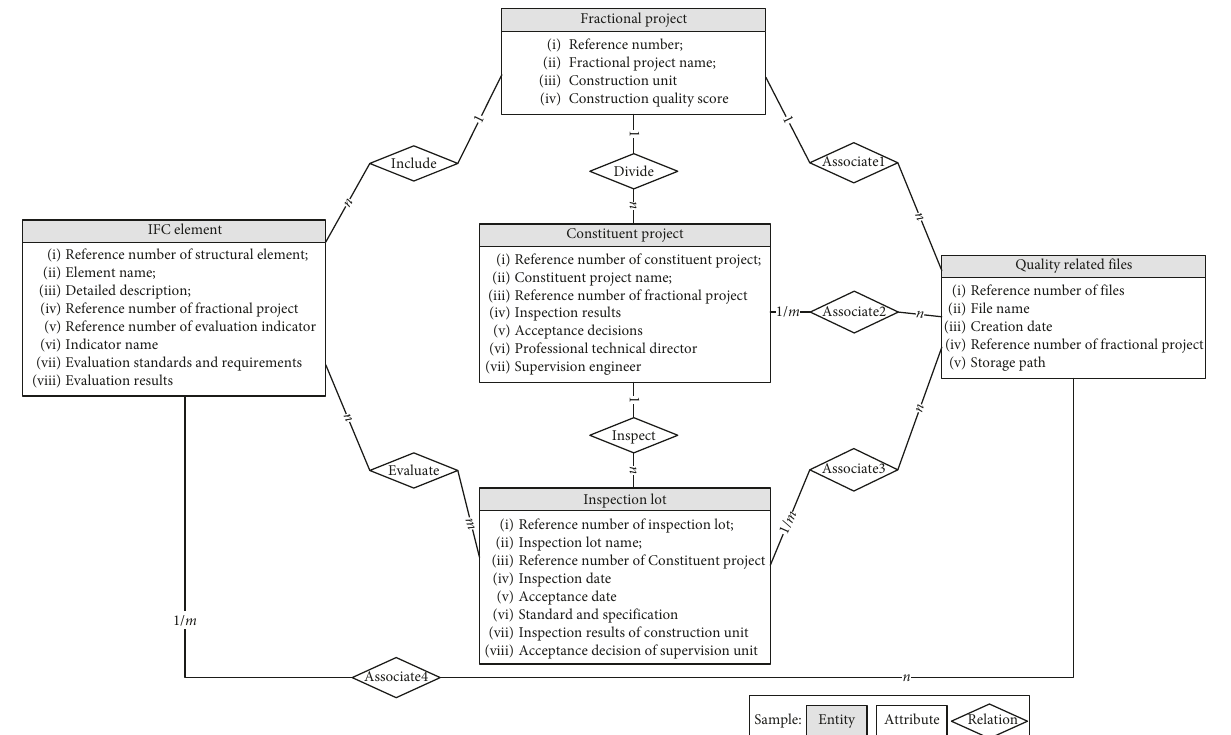
Figure 9: The workflow of quality database operation.